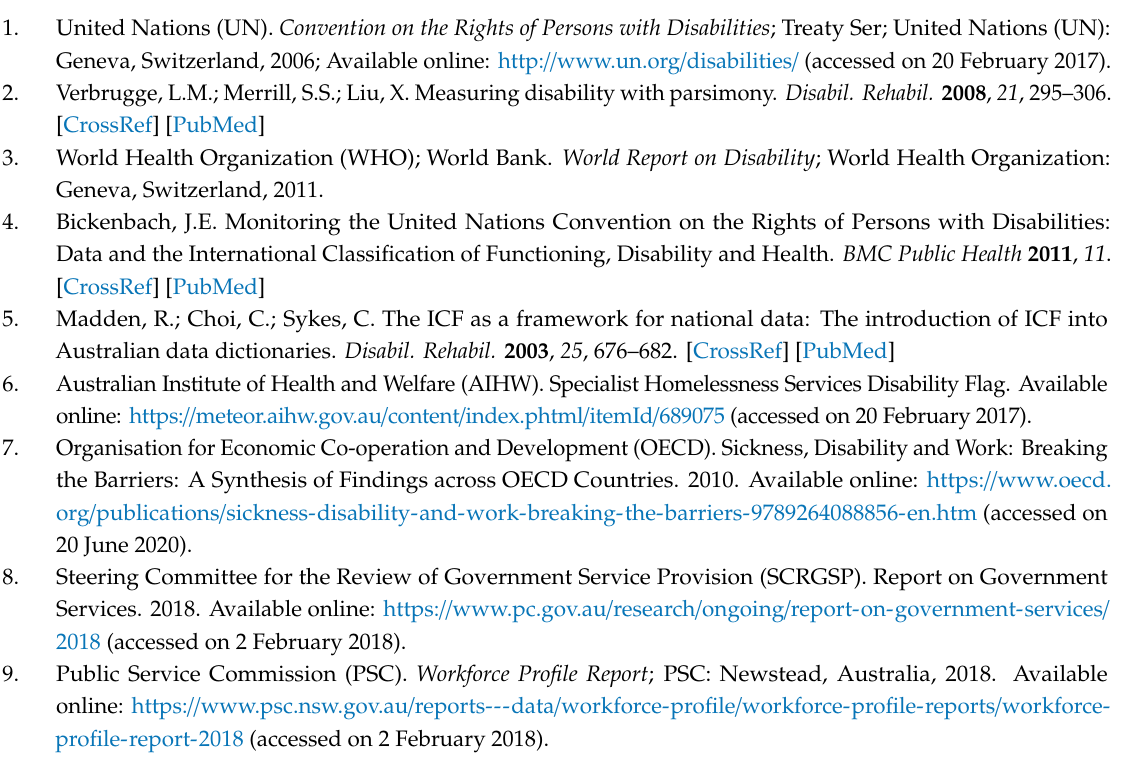
Supplementary S1: Questions for focus groups to discuss. Supplementary S2: Online survey questions. Table S1: Mapping 10 instruments to the ICF – overview. Table S2: Responses to disability questions. Table S3: Responses to environment questions. Table S4. Characteristics of Workforce Profile compared to People Matter Employee